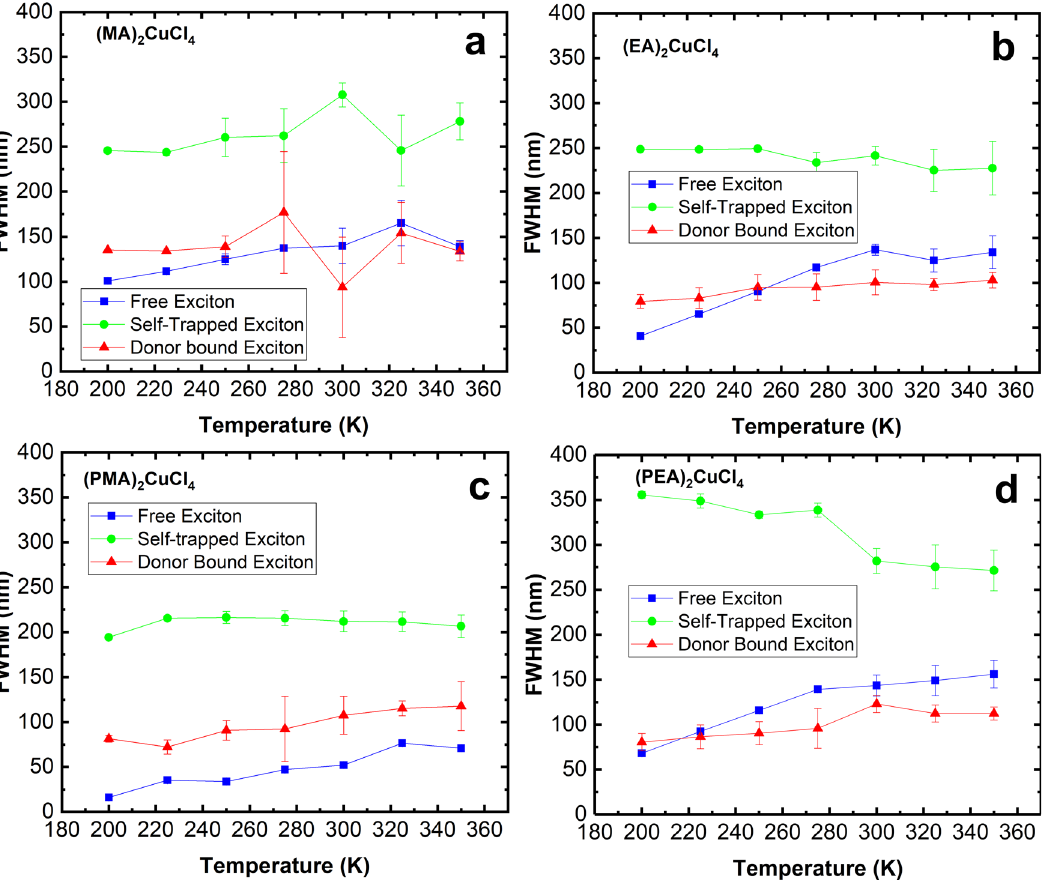
Fig. 6 The overview of FWHM extracted from the PL spectra of A 2 CuCl 4 compounds. (MA) 2 CuCl 4 ( a ), (EA) 2 CuCl 4 ( b ), (PMA) 2 CuCl 4 ( c ), and (PEA) 2 CuCl 4 ( d ), respectively. Self-trapped exciton (green circles), donor bound exciton (red triangles), and free exciton (blue squares). Error bars are collected from the respective fi tting